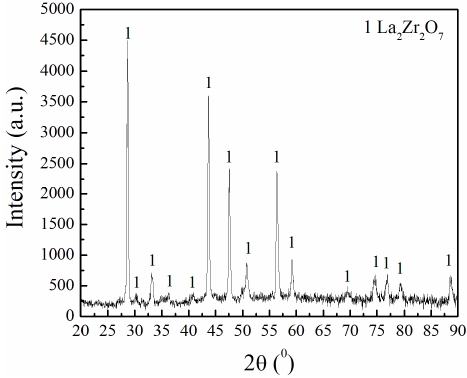
Figure 2. SEM images of the laser clad La 2 Zr 2 O 7 /NiCoCrAlY coating: ( a ) whole, ( b ) at position A, ( c ) at position E, ( d ) at position B, ( e ) at position C. (A, B and C represent the top, middle and bottom of the coating, respectively. D and E repre- sent the locally amplified La 2 Zr 2 O 7 layer and alloying layer at position A, respectively. Numbers 1–7 represent substrates or particles at corresponding positions of the coating.).